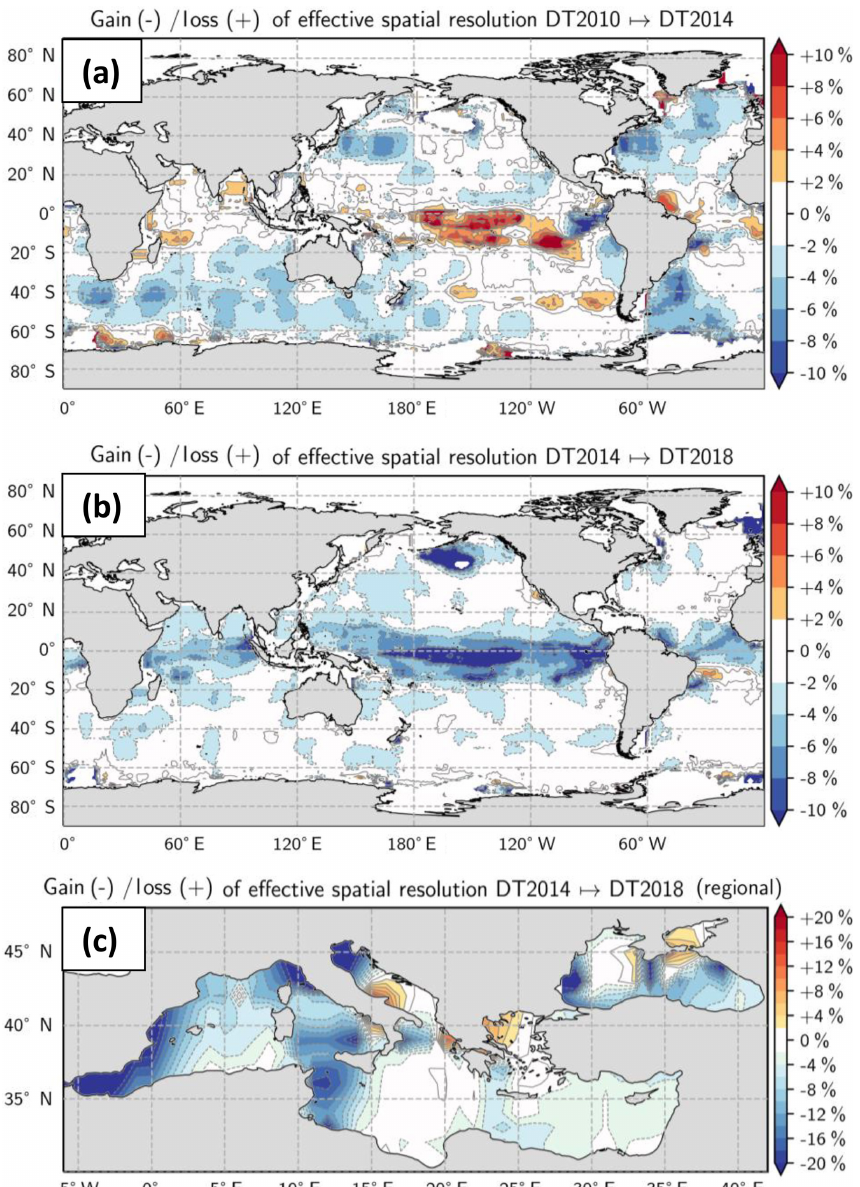
Figure 4. Gain/loss of effective spatial resolution for (a) the Global Ocean product between DT2014 and DT2010, (b) the Global Ocean product between DT2018 and DT2014 and (c) the Mediterranean Sea product and the Black Sea products between DT2018 and DT2014. Negative values mean that the resolution capability is finer. Note the different color bar scale between global and regional